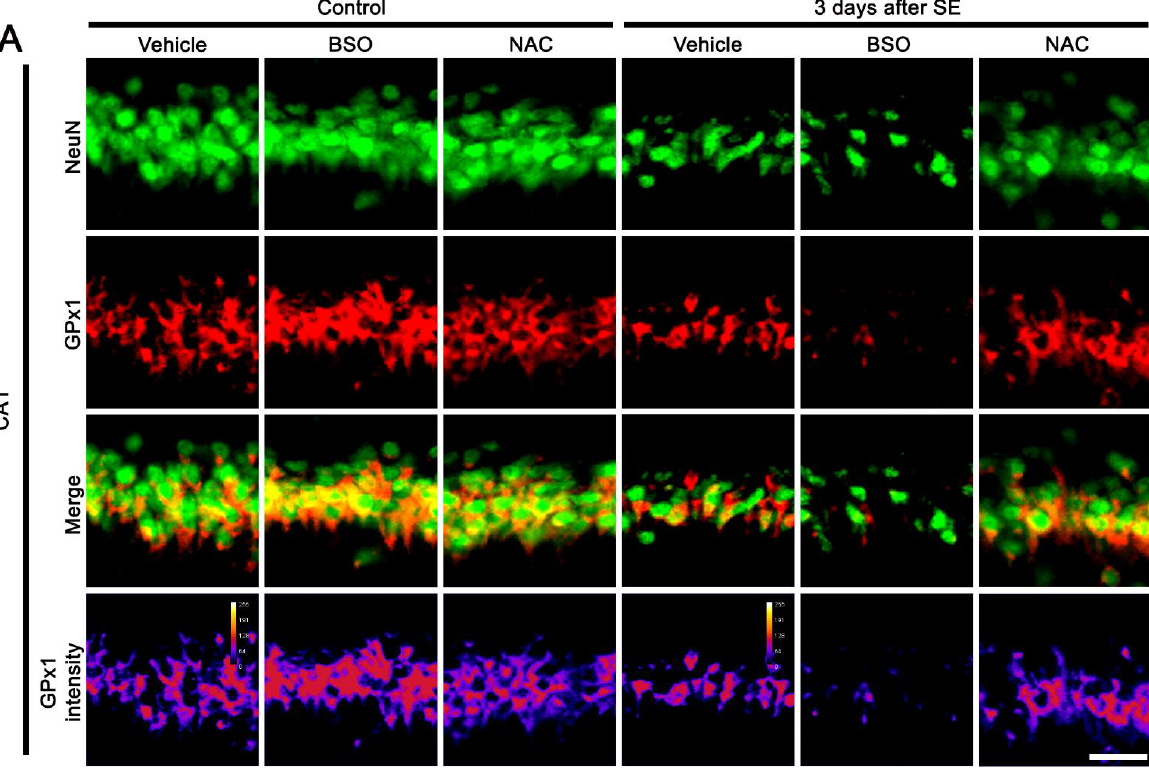
Figure 3. Effects of BSO and NAC on GPx1 expression in CA1 neurons under physiological- and 3 day-post-SE conditions . Under physiological conditions, BSO increases GPx1 expression, while NAC does not affect it, as compared to vehicle (Veh). Three days after SE, BSO aggravates SE-in- duced CA1 neuronal death accompanied by the reduced GPx1 expression. NAC attenuates SE-in- duced CA1 neuronal loss and decreased GPx1 expression. ( A ) Representative photos of GPx1 ex- pression and its intensity. Bar = 25 μm. ( B , C ) Quantification of NeuN ( B ) and GPx1 ( C ) intensity in CA1 neurons (C) (*, # p < 0.05 vs. control and vehicle, n = 7, respectively).